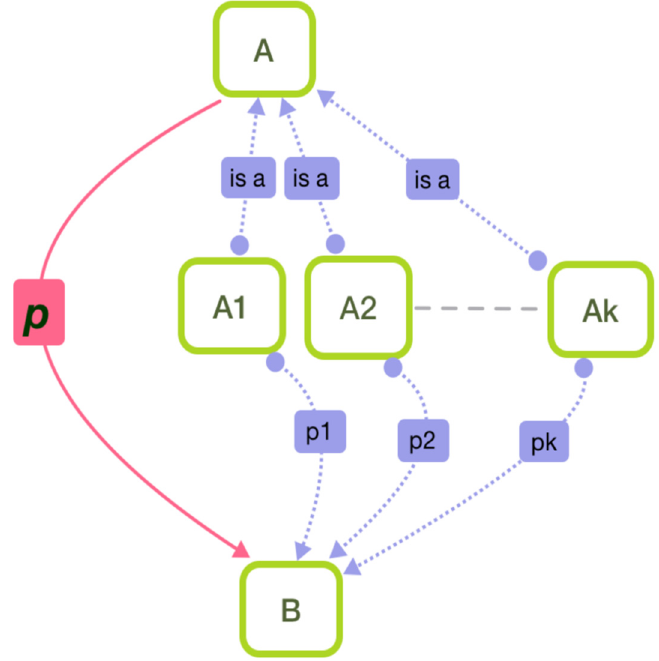
Figure 3. Convert subclass property to superclass.